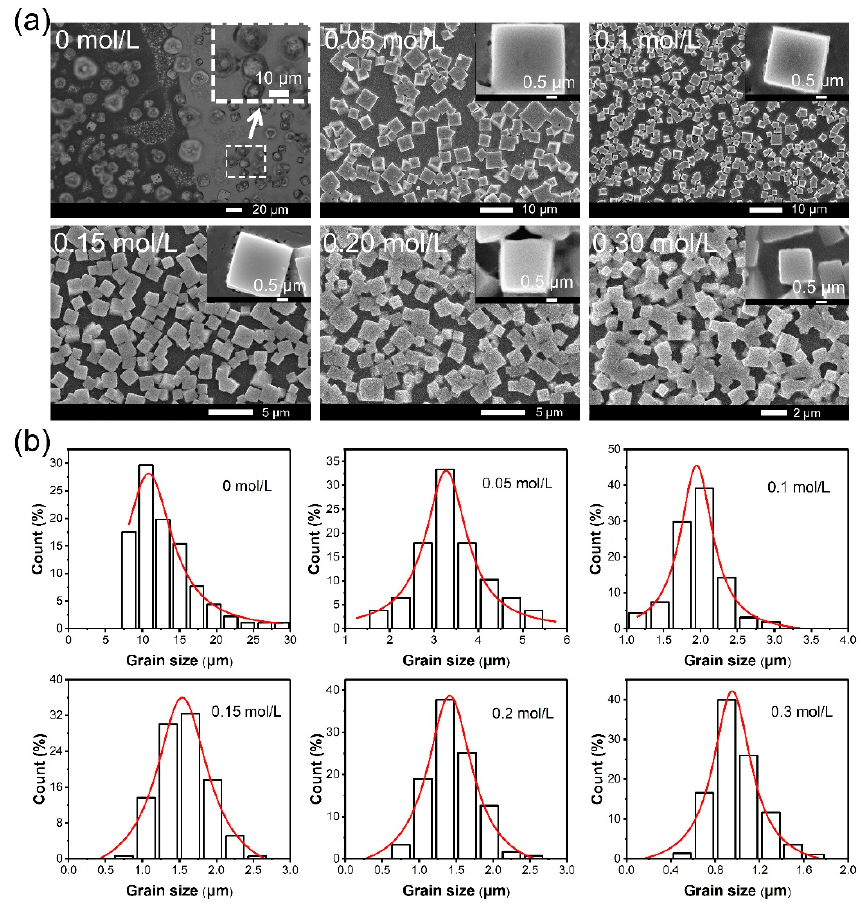
Figure 2. ( a ) Top-view microscopic images of perovskite films with various PEAI concentrations. ( b ) The grain size distribution of perovskite films at various PEAI concentrations.